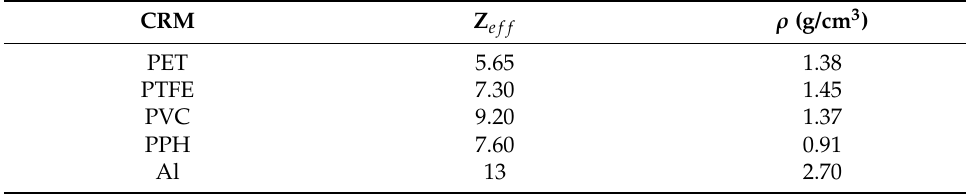
Table 1. Z ef f and ρ values of chosen CRM used for